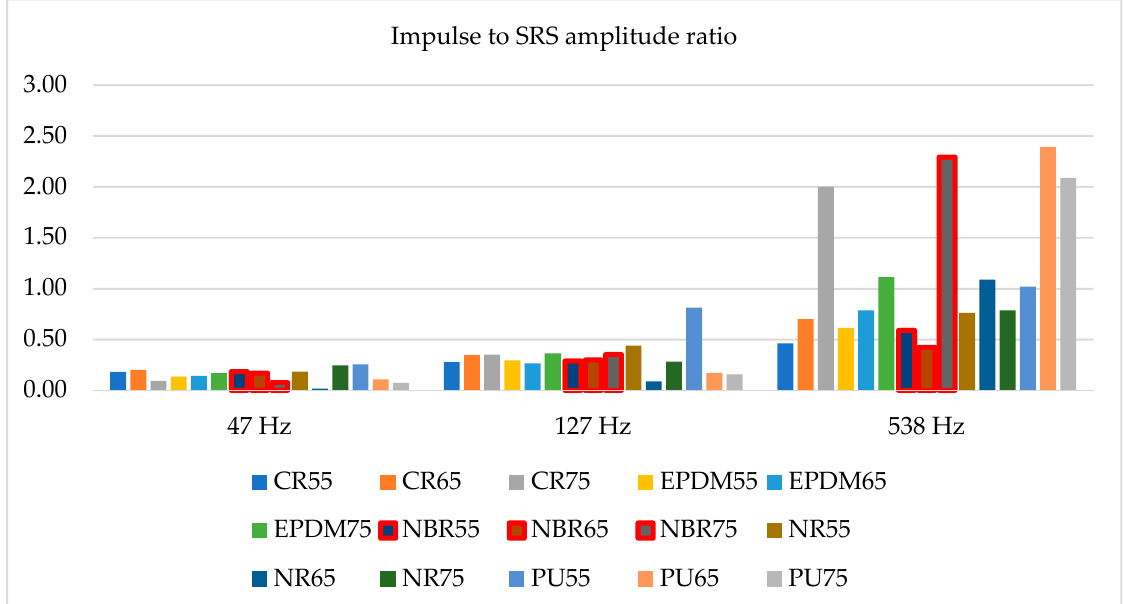
Figure 10. Impulse to SRS amplitude ratio for hammer drop down from 300 mm.